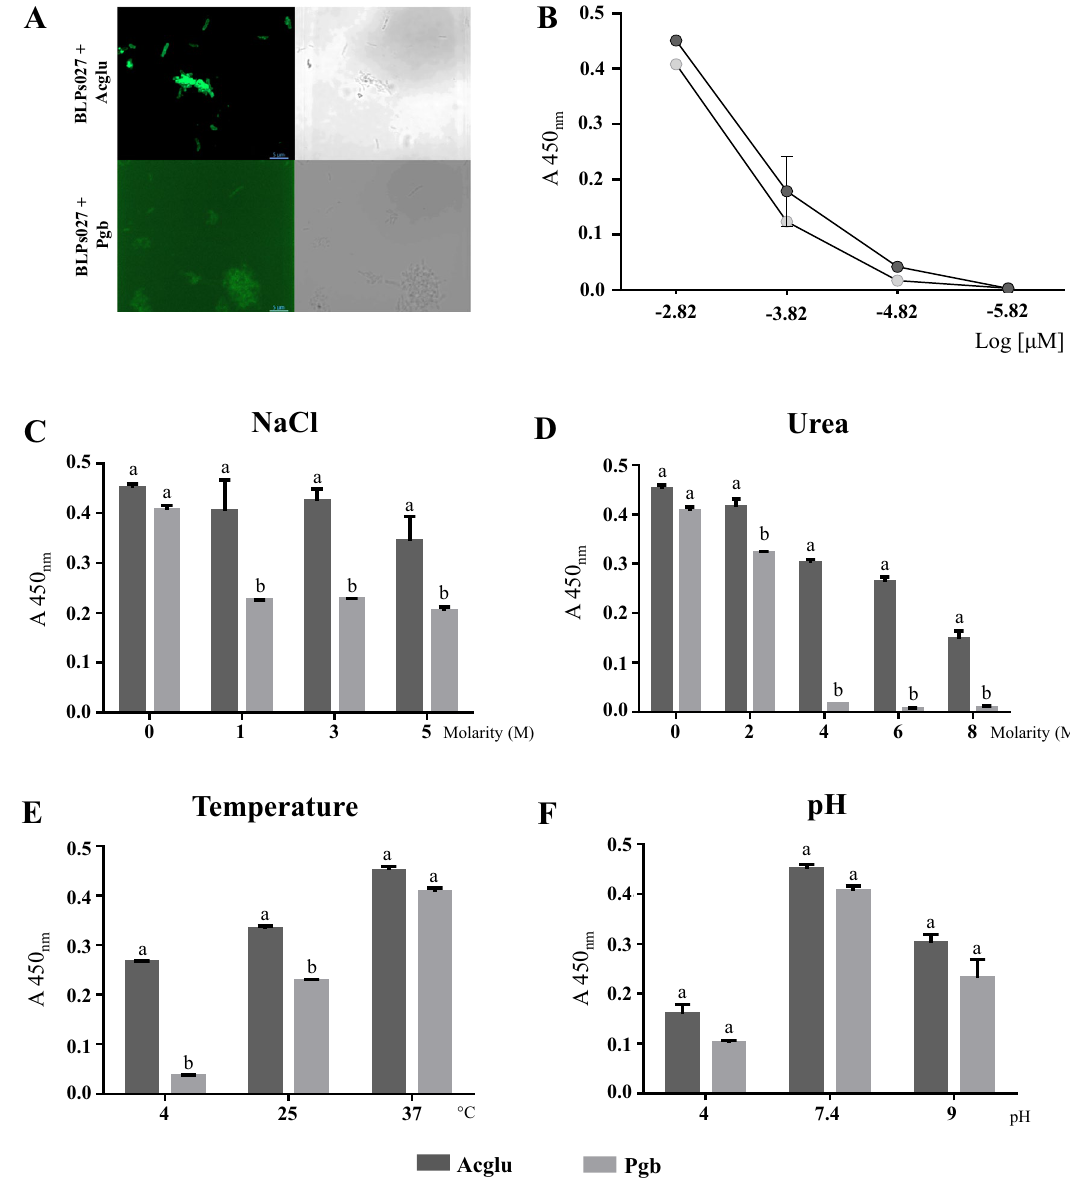
Figure 1. Binding of Venus-LysM proteins to bacterium-like particles (BLPs). (A) Fluorescence microscopy analysis of Venus-Acglu and Venus-Pgb proteins obtained from the inclusion bodies bound to BLPs from Lacticaseibacillus rhamnosus IBL027 (BLPs027) . (B) Detection of binding affinity of different concentrations of Venus-Acglu and Venus-Pgb to BLPs027 by ELISA. (C) Influence of NaCl molarity (1 M, 3 M and 5 M), (D) urea molarity (2 M, 4 M, 6 M and 8 M), (E) temperatures (4, 25 and 37 °C), and (F) pH (4, 7.4 and 9) on the binding affinity of Venus-Acglu and Venus-Pgb proteins to the BLPs027. Different letters above bars indicate significant differences between groups in the same condition. P < 0.05 was considered